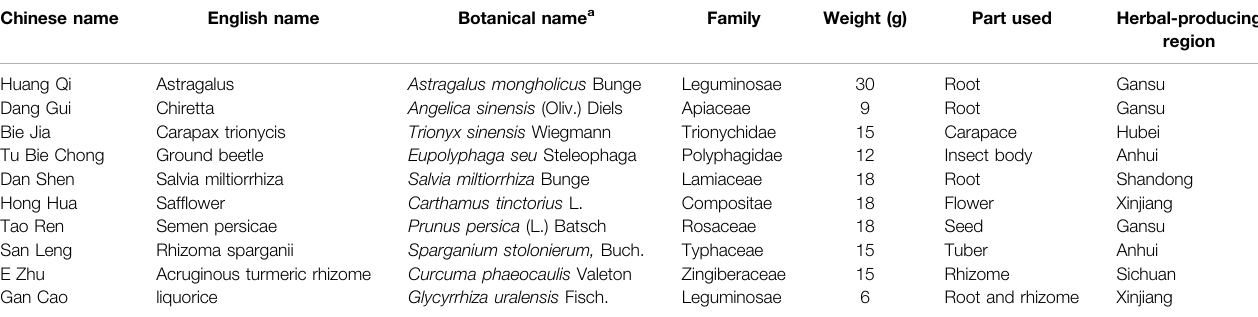
TABLE 1 | The composition of Qijia Rougan decoction.